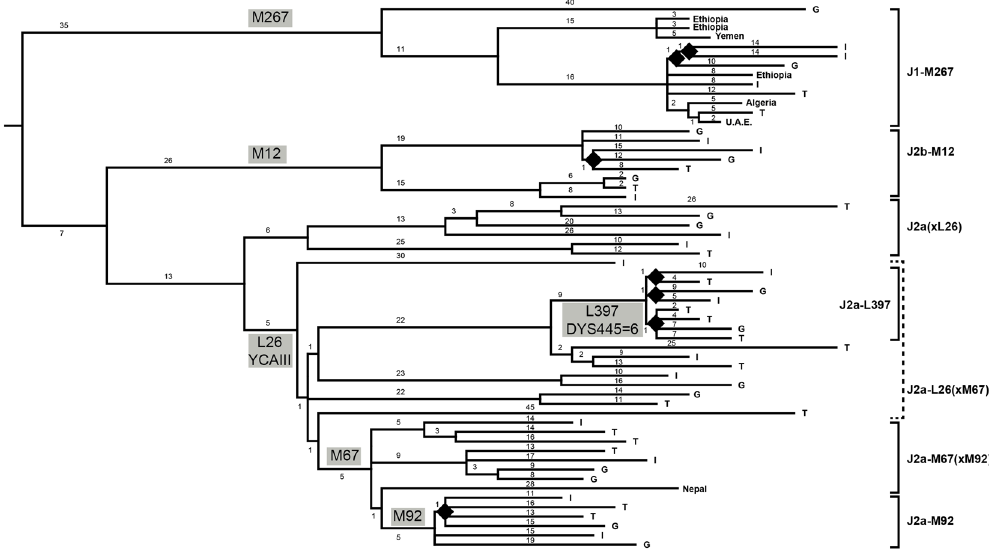
Figure 1. Unrooted MP tree of 58 Hg J chromosomes based on 1079 variable positions (Supplemental Table 2), with the root placed based on the reference sequence. The seven groupings used in the initial selection of samples are shown on the right. The provenance of subjects is abbreviated for Italy (I), Greece (G) and Turkey (T), or in full for other locations. The markers for the definition of clades and selection of samples are shown next to the branches where they occur, in grey boxes. The number of SNPs defining each branch (branch length) is also reported. Black lozenges indicate nodes discussed in the text, for which specific SNP assays were